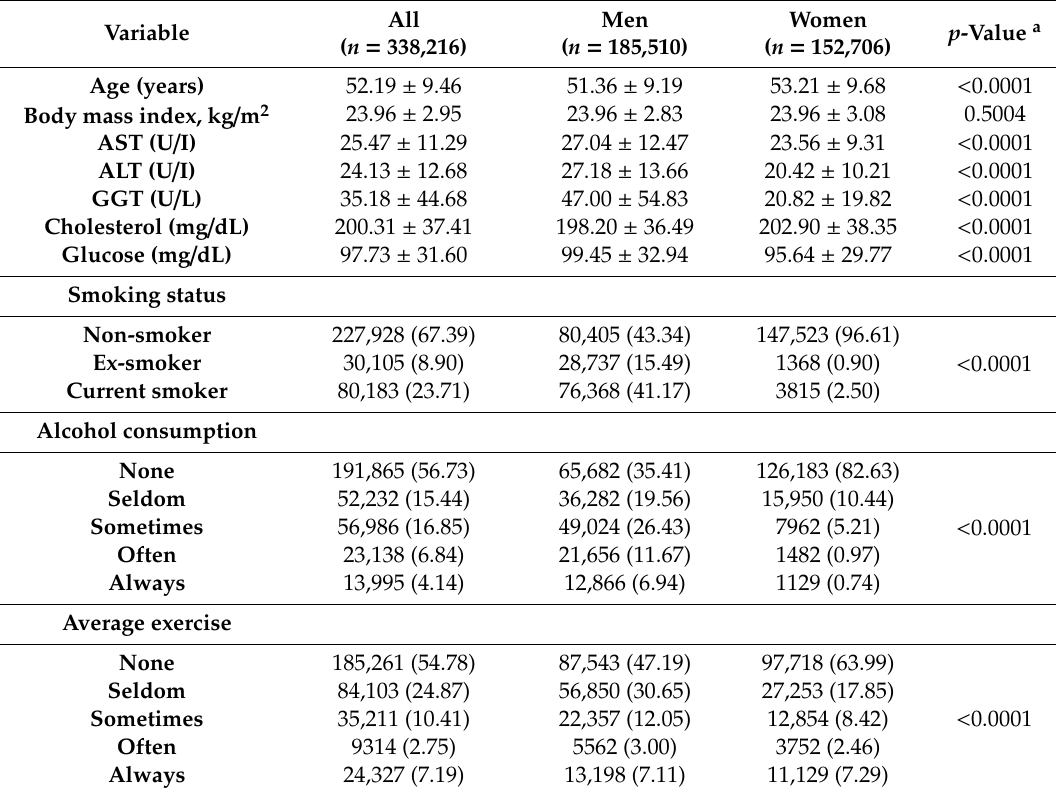
Figure 1. Patient enrollment flow chart. Table 1. Baseline